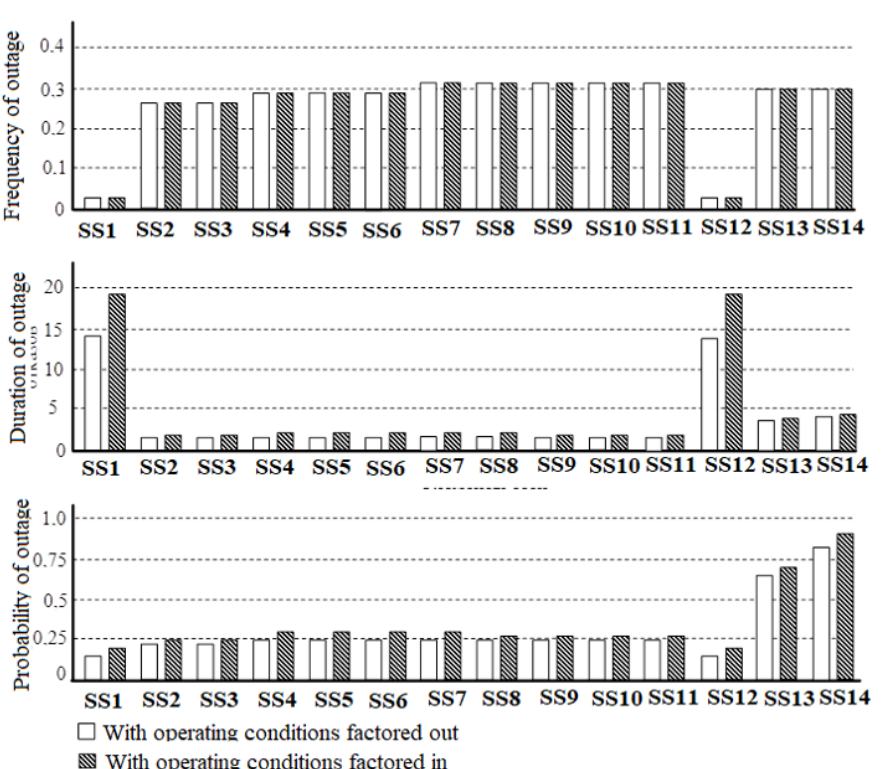
Figure 7. Reliability metrics for Structure 1 of the distribution network.